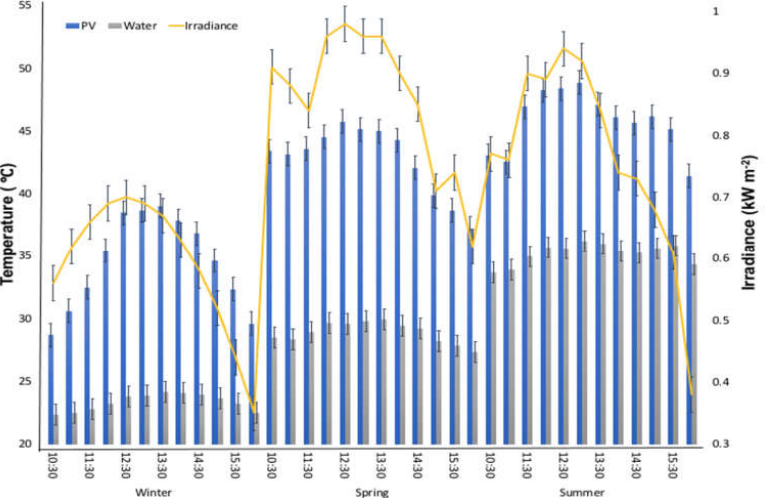
Figure 7. Irradiance, cooling water and PV temperature during operation in winter, spring and summer.